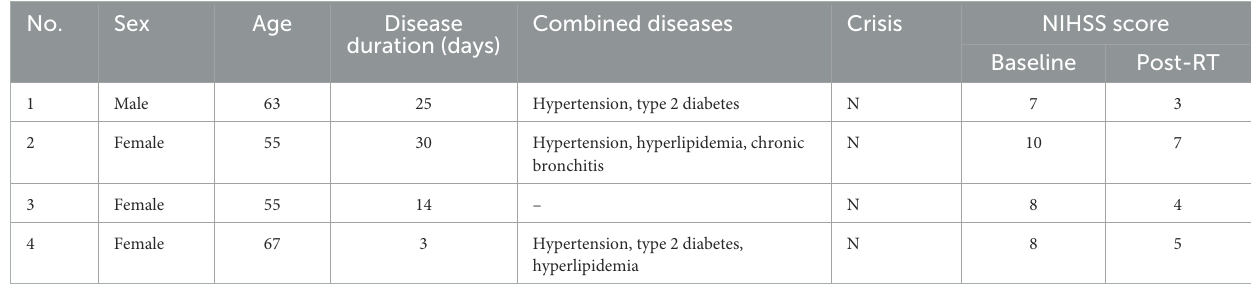
TABLE 2 Clinical characteristics of four ischemic stroke patients.